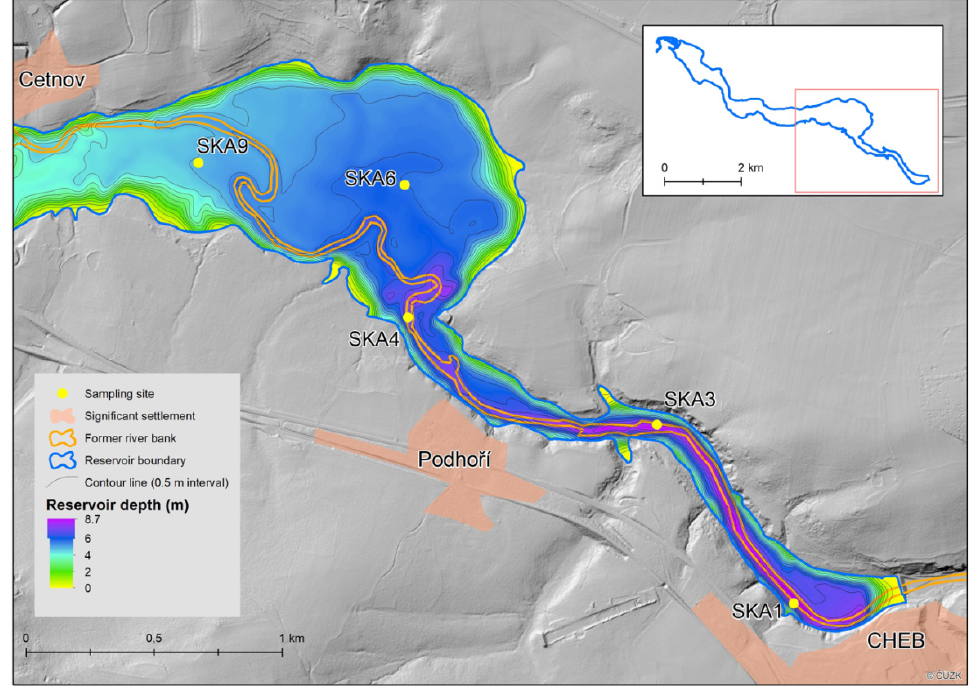
Figure 2. Positions of studied gravity cores in the Skalka Reservoir, showing varying depths and distances to thalweg and dam.